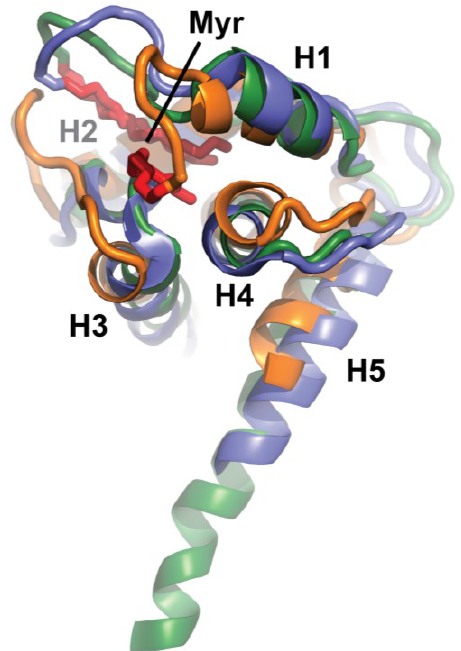
Figure 6. Best-fit superposition of helix backbone atoms of representative myrMA Q5A/G6S (orange), myrHIV-1 MA (blue, PDB: 2H3I) and myrHIV-2 MA (green, PDB